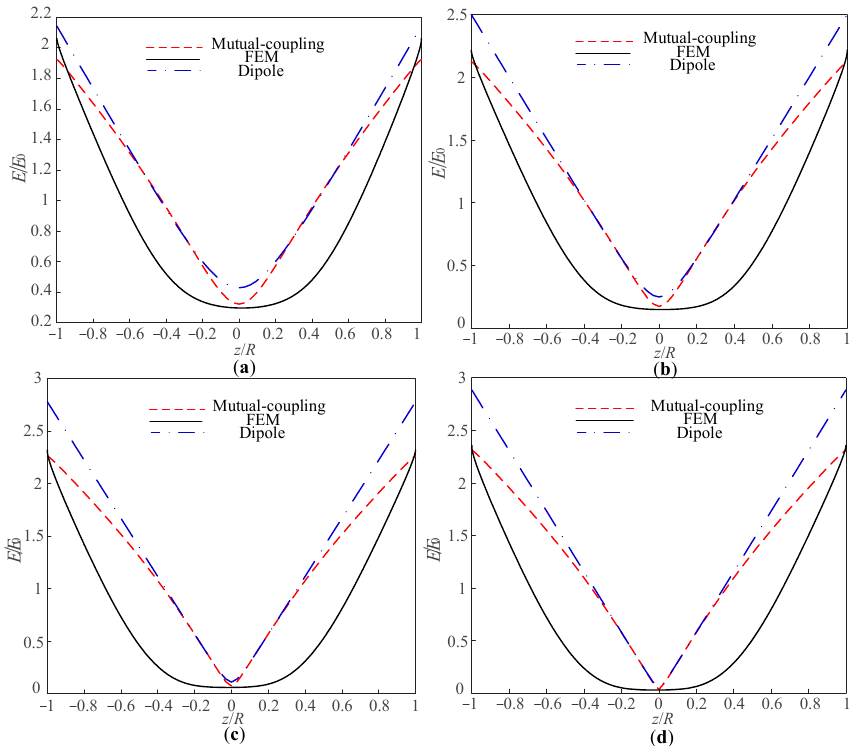
Figure 9. Calculation results of the electric field distribution on particle 1 when D / R = 0.2: ( a ) Calcu- lation results when ε i / ε e = 5; ( b ) Calculation results when ε i / ε e = 10; ( c ) Calculation results when ε i / ε e = 25; ( d ) Calculation results when ε i / ε e = 50.